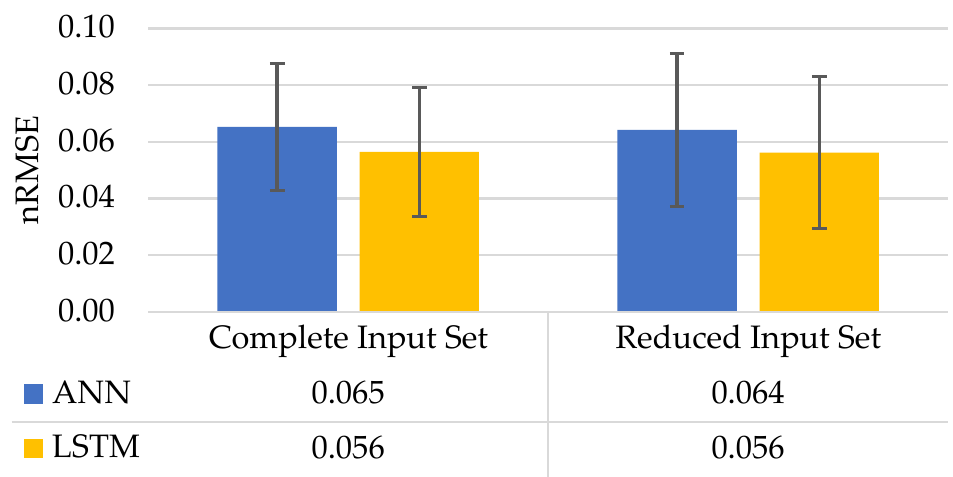
Figure 6. Prediction accuracy between Complete Input Set and Reduced Input Set by model.